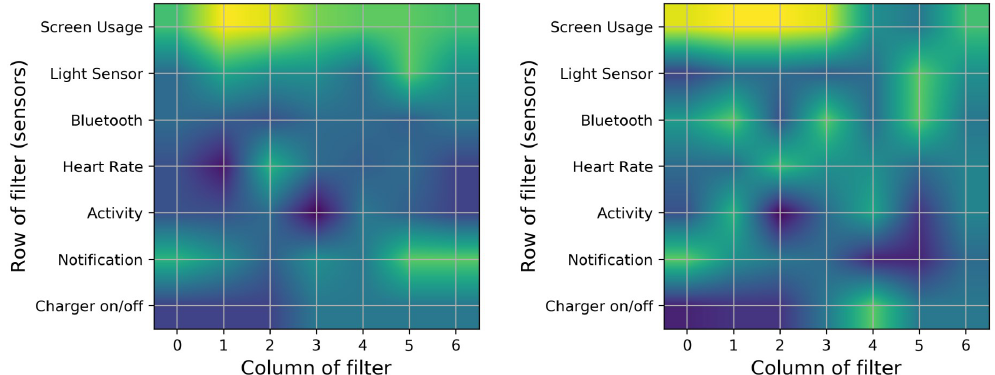
Figure 7. Average of 32 filters’ heat maps for two individual training sessions. The brightest regions highlight the sensor’s focus on extracting symptoms from inputs. The brightest regions show the sensor’s